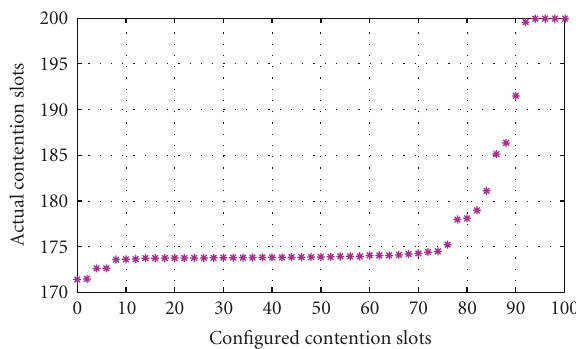
Figure 7: The actual contention slots versus the configured contention slots, V = 10.